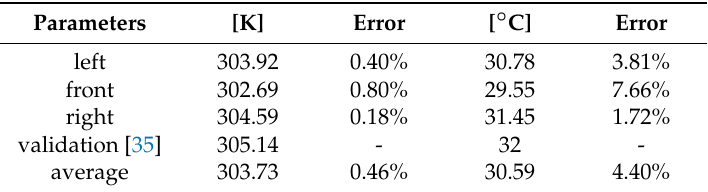
Table 2. Average face temperature values for